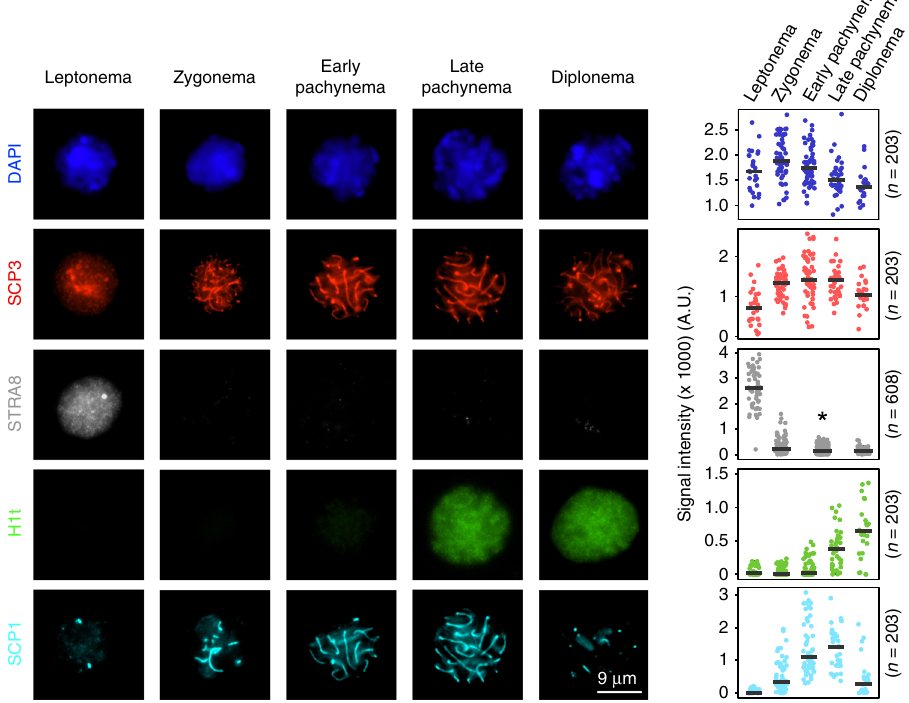
Fig. 1 Immuno fl uorescence staining of spermatocyte nuclei. Immuno fl uorescence images and signal quanti fi cation of stage-speci fi c spermatocyte nuclei through meiosis prophase I. Details for signal quanti fi cation are described in Methods. Microscopic images are selected from two independent experiments in which two different combinations of primary antibodies are used; one using SCP3, H1t and SCP1, another one using SCP3 and STRA8. *Early and late pachytene nuclei cannot be unambiguously differentiated in the absence of H1t staining, and are therefore merged for counting and signal quanti fi cation. Source data are provided as a Source Data fi